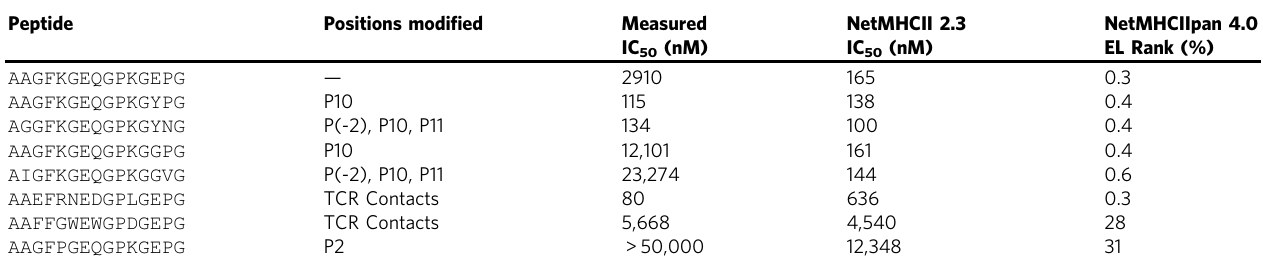
Table 2 Effect of preferences at TCR contacts and positions outside the peptide core. Table of modi fi ed CII 261-273 peptides with associated measured IC 50 values and the predictions of selected MHC-II prediction algorithms. Peptide Positions modi fi ed